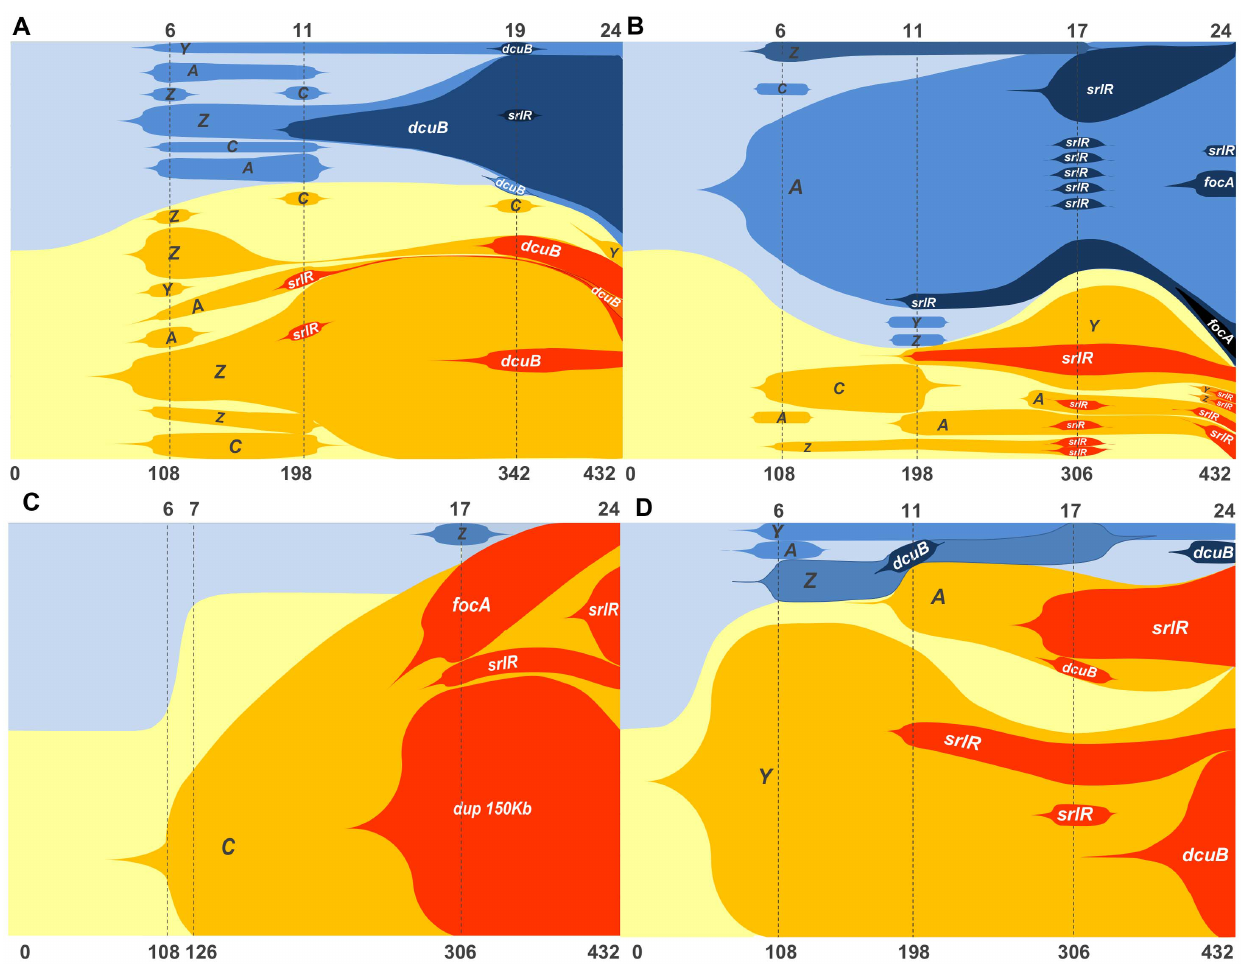
Figure 5. Graphic representation of the frequencies of newly generated haplotypes along 24 days (corresponding to 432 generations) of evolution inside the mouse gut (see Tables S3 to S6 for numeric data). Shaded areas are proportional to the relative abundance of each haplotype. Yellow and blue shaded areas represent the two sub-populations of bacteria labeled either with cfp or yfp alleles. The ancestry relations between haplotypes can be inferred by the accumulation of new mutations in a previously existent genotype. Dash lines mark the time points in days (upper axis) or generations (lower axis) where the sampling took place. For the top two populations 1.1 (A) and 1.11 (B), 40 clones were sampled in each time point. For the bottom two populations 1.12 (C) and 1.5 (D) 20 clones were sampled in each time